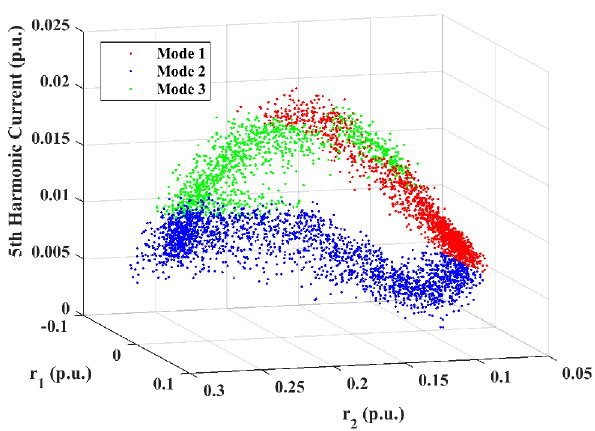
Figure 9. Modeling dataset.